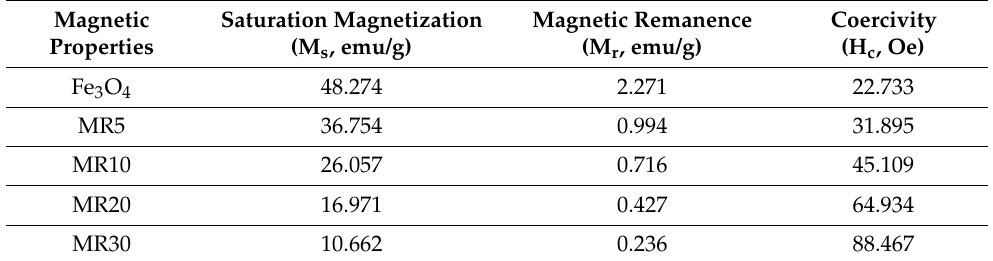
Table 3. A summary of the magnetic properties of the Fe 3 O 4 and Fe 3 O 4 @RGO composites.